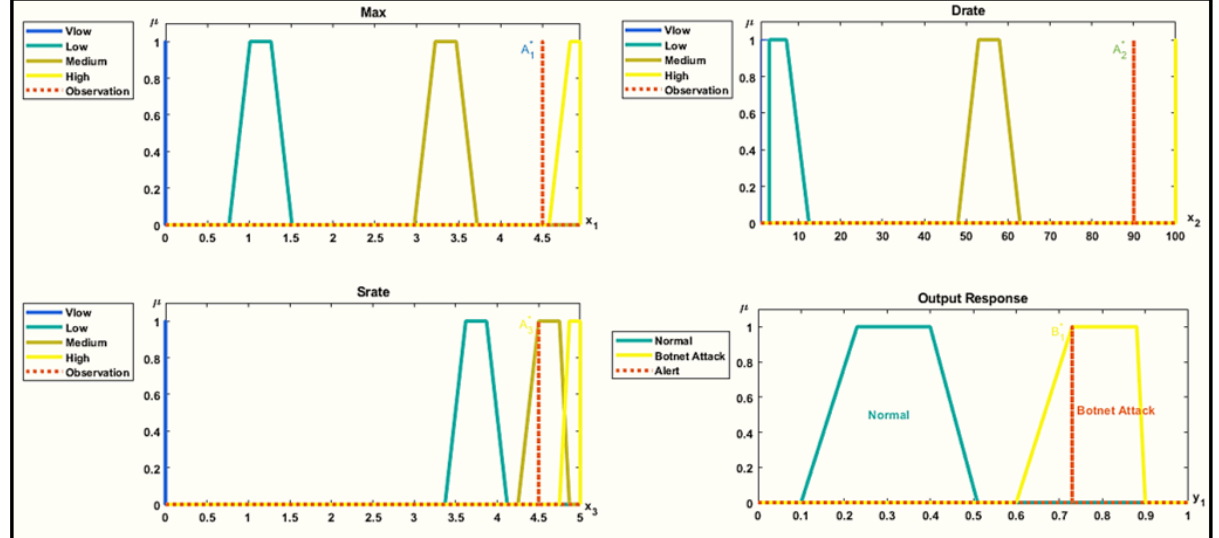
Figure 3. The Output Response of the Suggested Detection Approach.